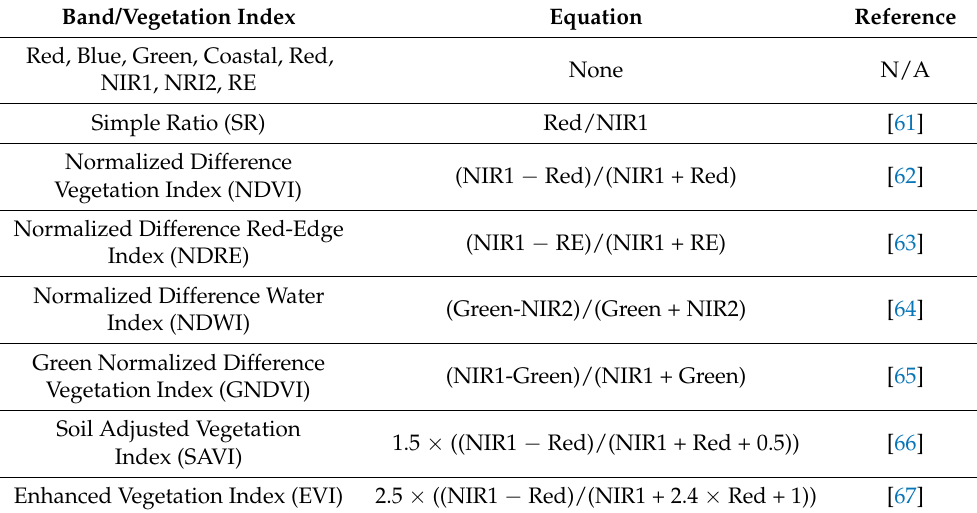
Table 1. WorldView-2 bands and vegetation indices used in the 2012 wetland classification. NIR = near-infrared; RE = red edge. Band/Vegetation Index Equation Reference Red, Blue, Green, Coastal, Red, None N/A NIR1, NRI2, RE Simple Ratio (SR) Red/NIR1 [61] Normalized Difference (NIR1 − Red)/(NIR1 + Red) Vegetation Index (NDVI) Normalized Difference Red-Edge Index